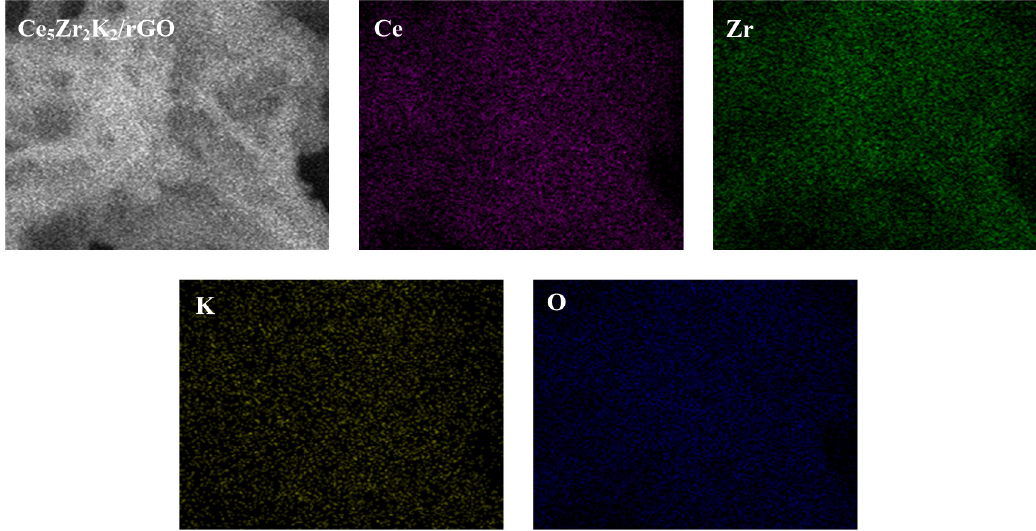
Figure 3. Energy dispersive X-ray (EDX) elemental mapping of Ce 5 Zr 2 K 2 /rGO catalyst.